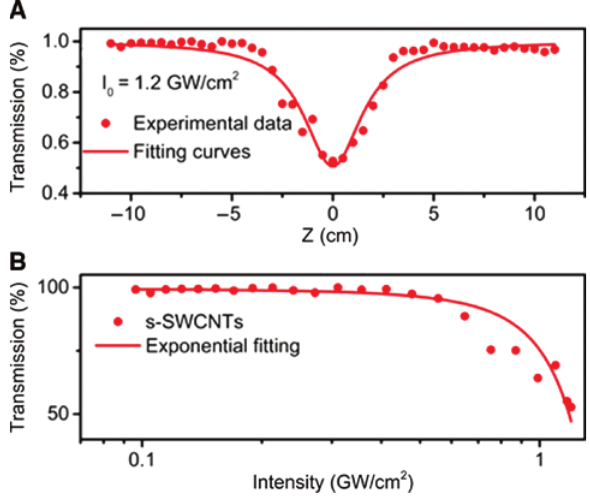
Figure 2: Typical optical-limiting property of s-SWCNTs. (A) Reversed saturable absorption at an incident intensity of 1.2 GW/cm 2 . (B) The optical limitation curve versus the incident intensity. Shi et al. [63] © The Royal Society of Chemistry